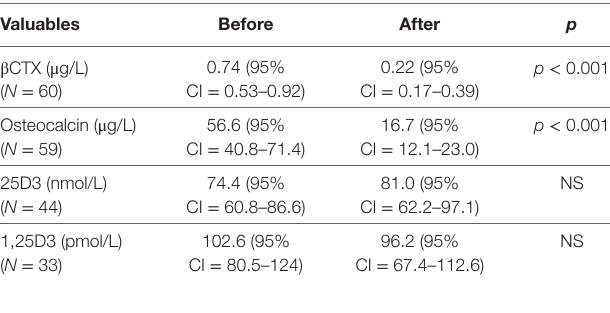
Table 3 | Changes of T score values following denosumab therapy (mean ± SD). graft lspine ( T score) Proximal femur ( T score) Forearm ( T score) before after p before after p before after p Pancreas and kidney